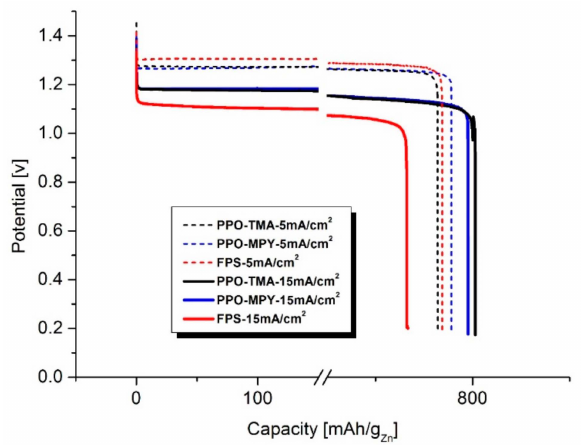
Figure 10. Galvanostatic discharge profile of the cells with PPO–TMA, PPO–MPY, and FPS as separator membrane at discharge current densities of 5 and 15 mA / cm 2